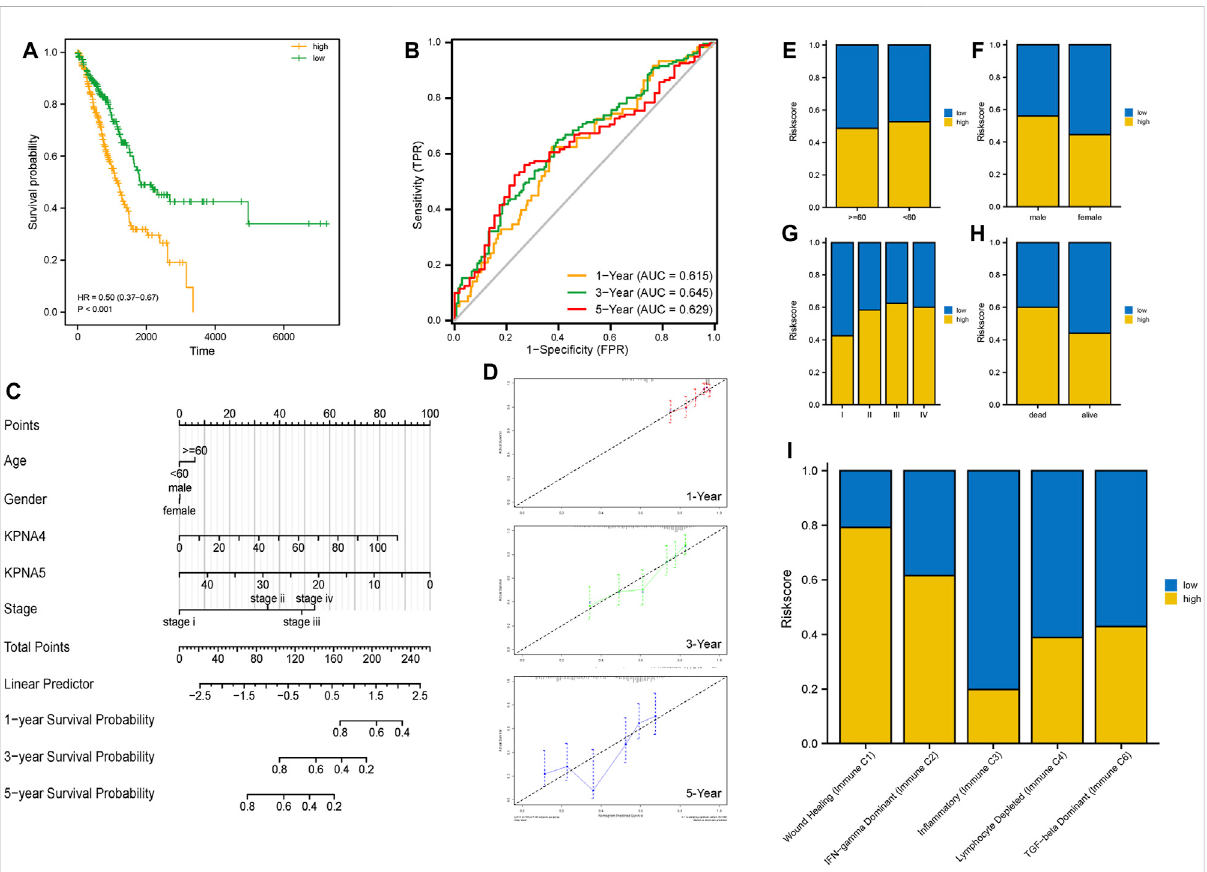
FIGURE 4 Evaluation of prognostic model and correlation analysis of clinical features (A) Analysis of prognosis in the two risk groups (B) ROC curves displaying the predictive value of the models for 1-year, 3-year, and 5-year survival outcomes (C,D) Prognostic nomogram and calibration curves according to clinical factors and the expression of KPNA4 and KPNA5 (E – I) Differences in clinical features between the two risk